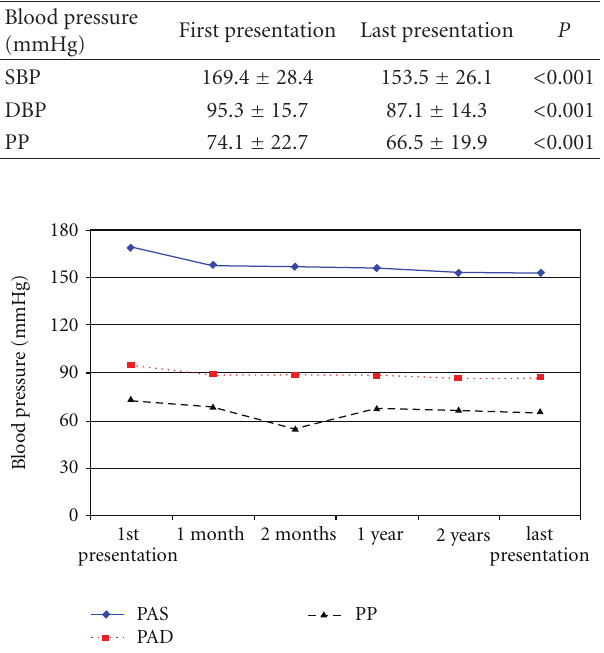
Figure 1: Changes in blood pressure during